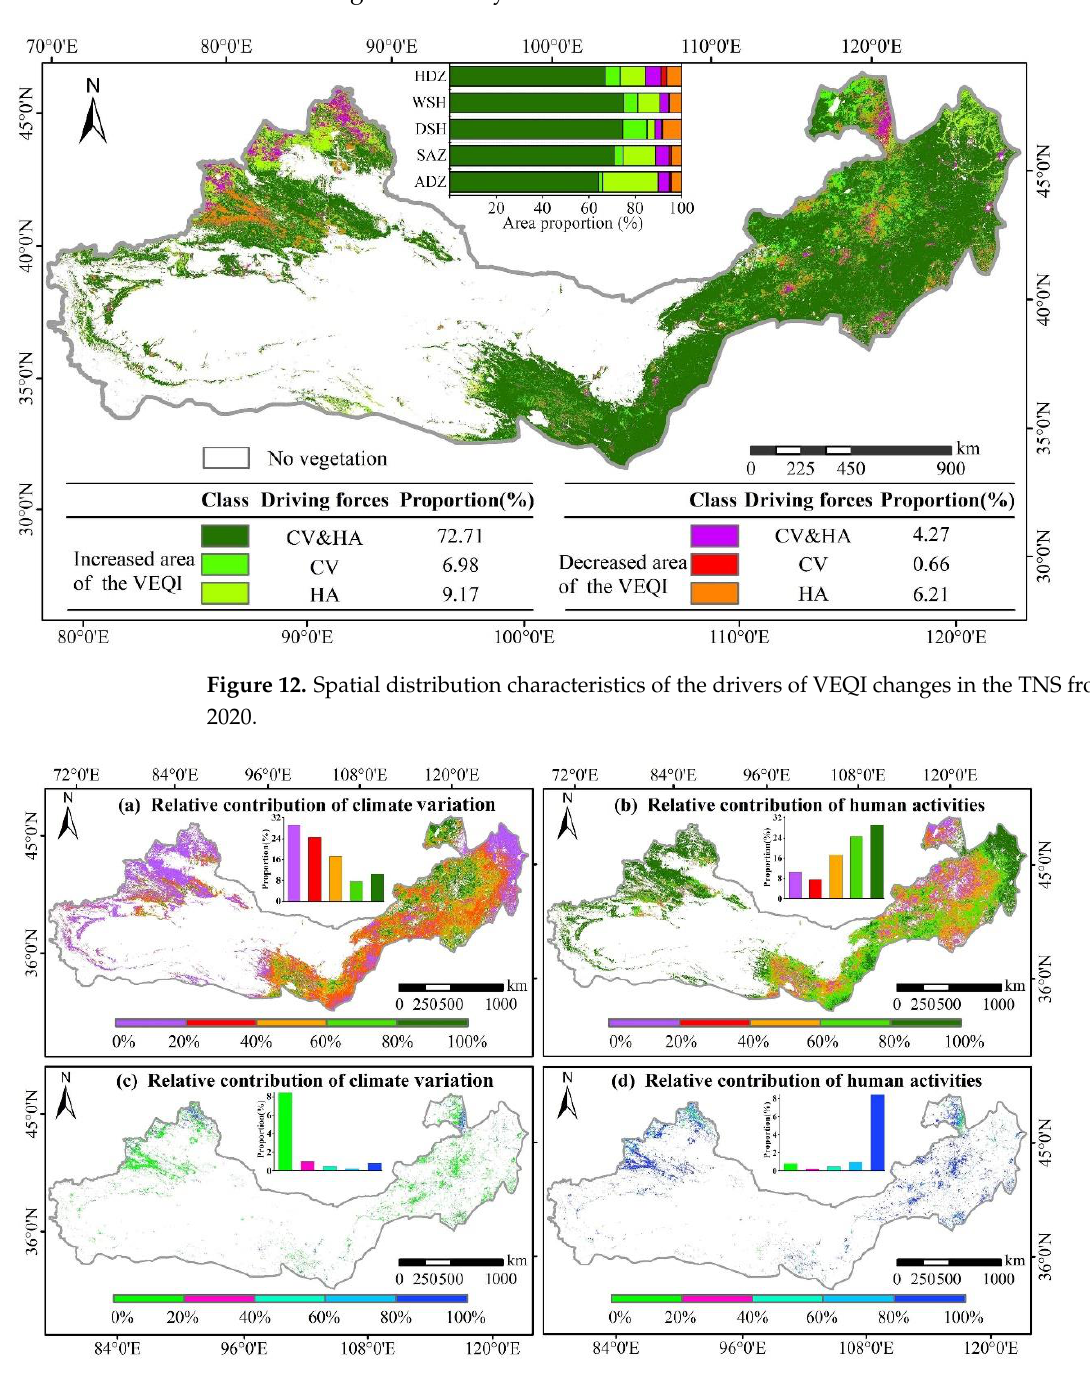
Figure 13. Relative contributions of climate variation and human activities to VEQI: ( a , c ) the relative contributions to VEQI of climate variation in increasing (decreasing) regions, respectively; ( b , d ) the relative contributions to VEQI from human activities in increasing (decreasing) regions, respec- tively.